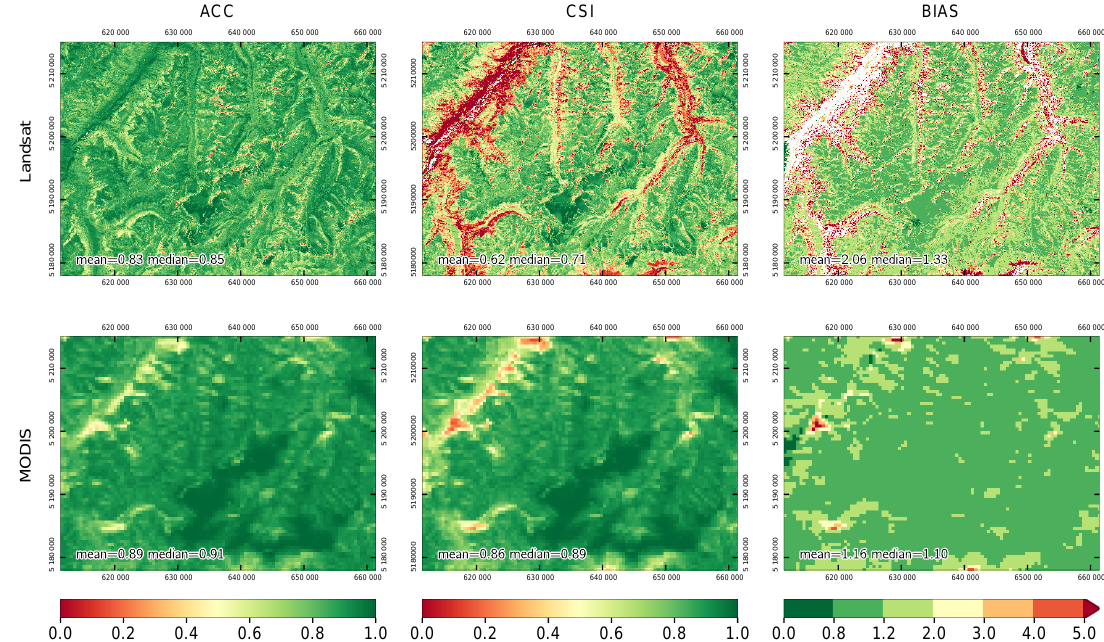
Figure 9. Pixel-based statistics of ACC, CSI, and BIAS over all selected Landsat and MODIS scenes.